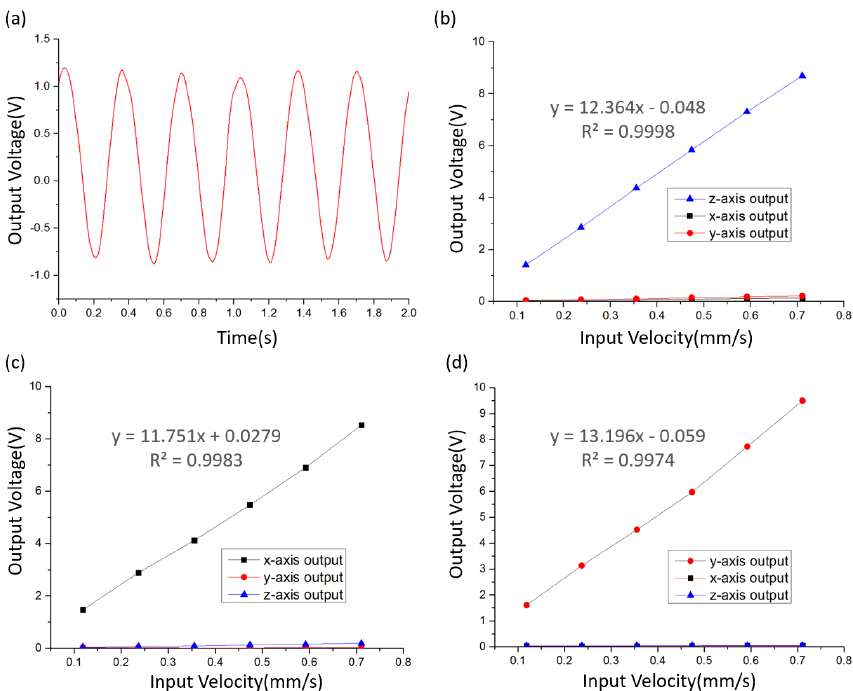
Figure 6. ( a ) The output voltage of the z-axis of the developed integrated triaxial electrochemical seismometer under the input velocity of 0.08 mm/s at 3 Hz along the z direction; ( b – d ) the output voltage of x-, y-, and z-axes of the developed integrated triaxial electrochemical seismometer by applying independent vibration of different amplitudes along x, y, and z directions.